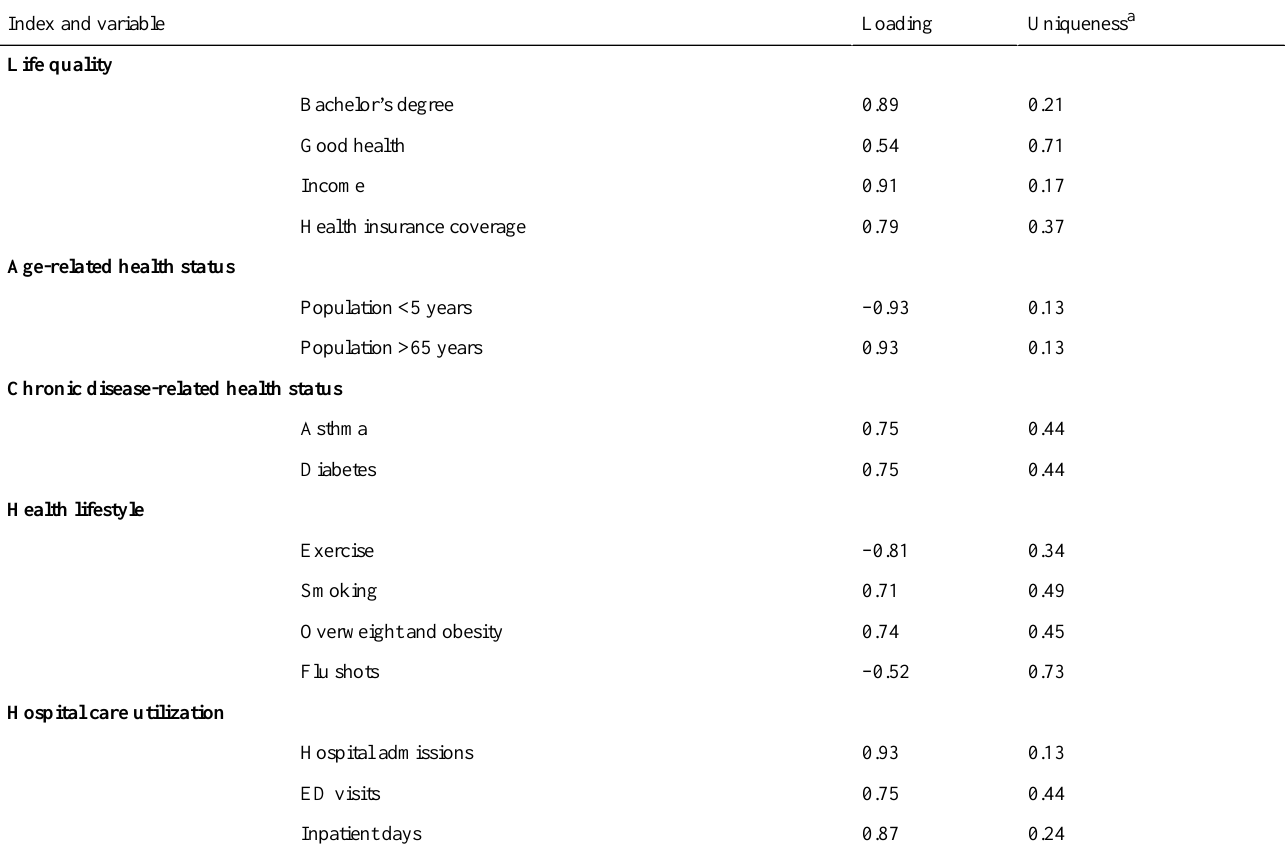
Table 4. Composite indexes from factor analysis.